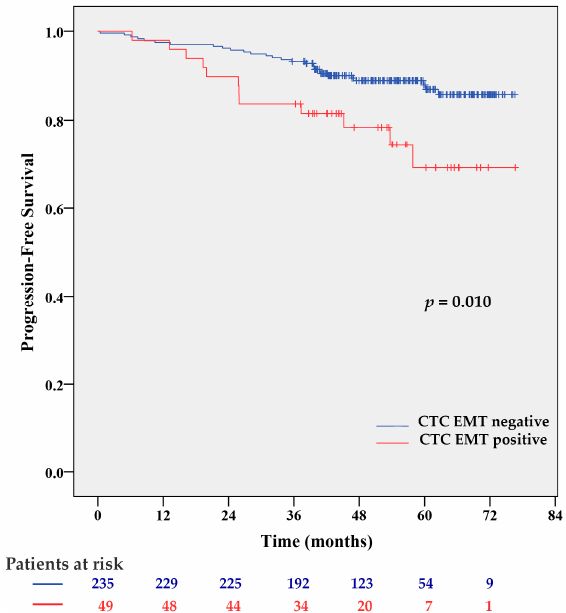
Figure 1. Kaplan–Meier PFS estimates for CTC EMT. CTC EMT-positive patients had significantly shorter progression-free survival (PFS) than CTC EMT-negative patients ( p = 0.010 by Log-rank test).